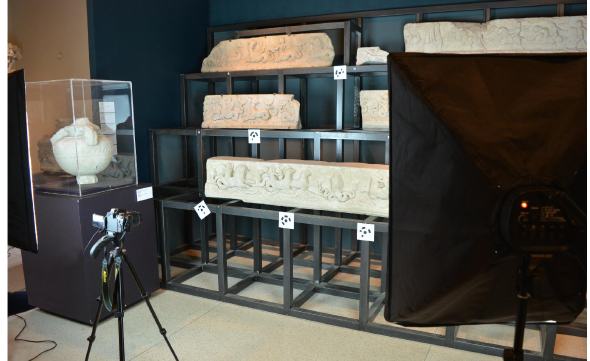
Figure 3. Image acquisition with reflex camera on tripod: